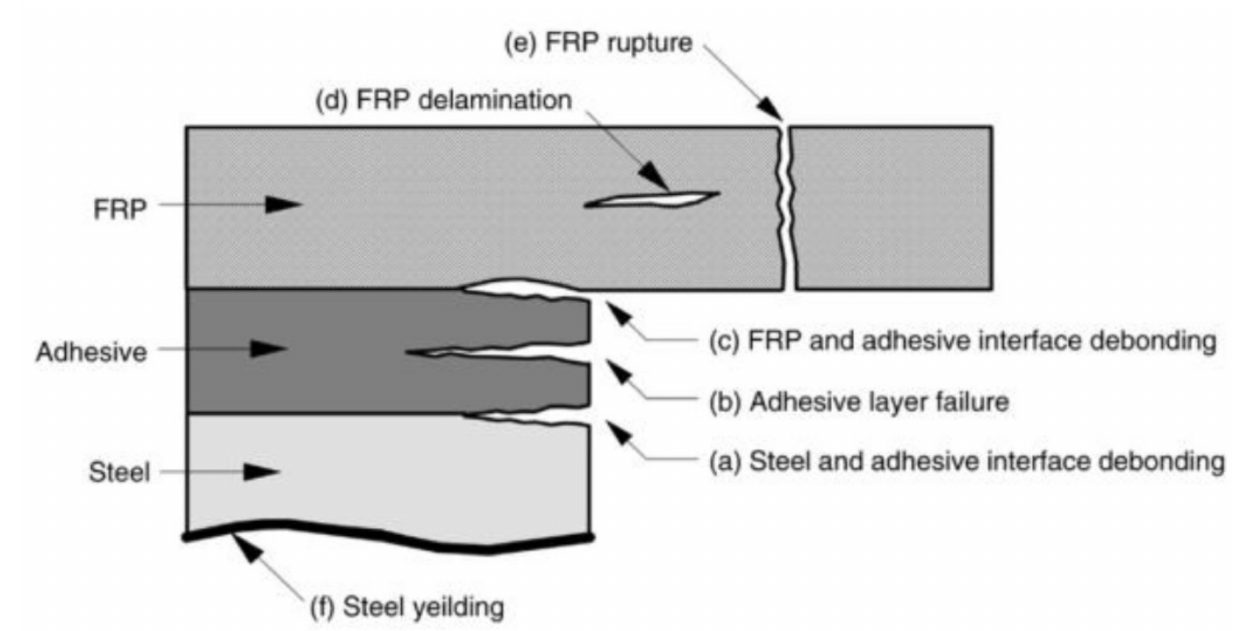
Figure 2. Schematic failure modes of adhered CFRP to steel joints [3,36], used with permission from Engineering structures, Elsevier,